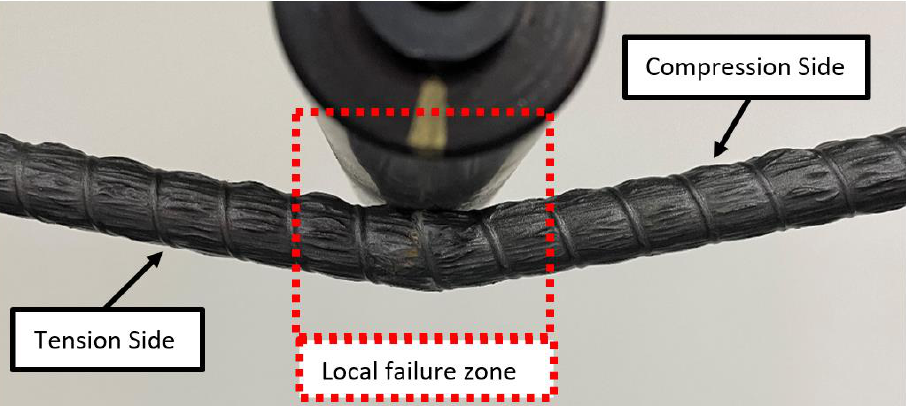
Figure 9. The 3-point bending test local failure zone .